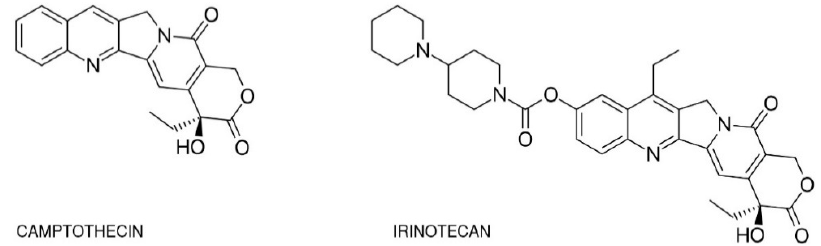
Figure 2. Chemical structures of camptothecin and irinotecan.